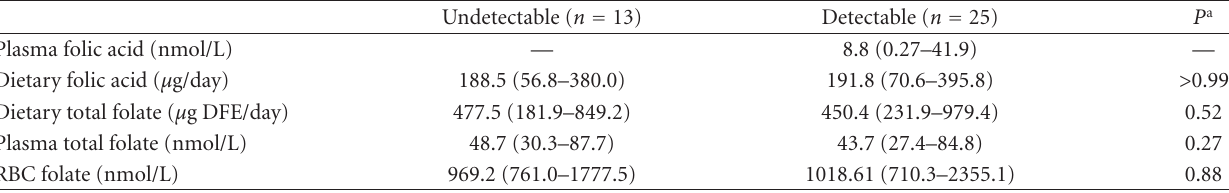
Table 3: Baseline dietary and biochemical data for participants with detectable or undetectable (i.e., below the LOD) plasma concentrations of unmetabolized folic